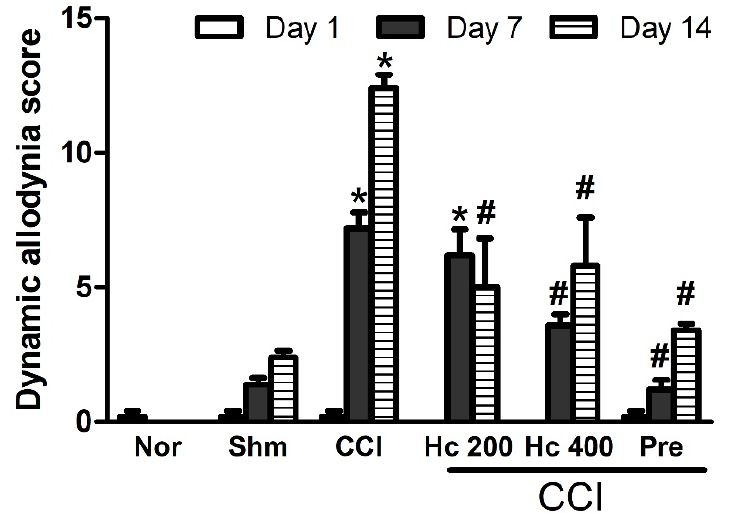
Figure 8. Effect of H. campechianum flower extract (p.o., 200 and 400 mg/kg) on mechanical dynamic allodynia in rats with neuropathic pain induced by ligation of spinal nerve. Withdrawals numbers of 15 trials in response to a stimulus induced by paint brush was noted (between 0 and 15). Data are presented as mean values ± S.E.M (n = 5). * p < 0.05, compared to the sham group; # p < 0.05, compared to the CCI group at the corresponding time points. CCI, chronic constriction injury; Hc, H. campechianum ; Nor, normal; Pre, pregabalin; Shm,